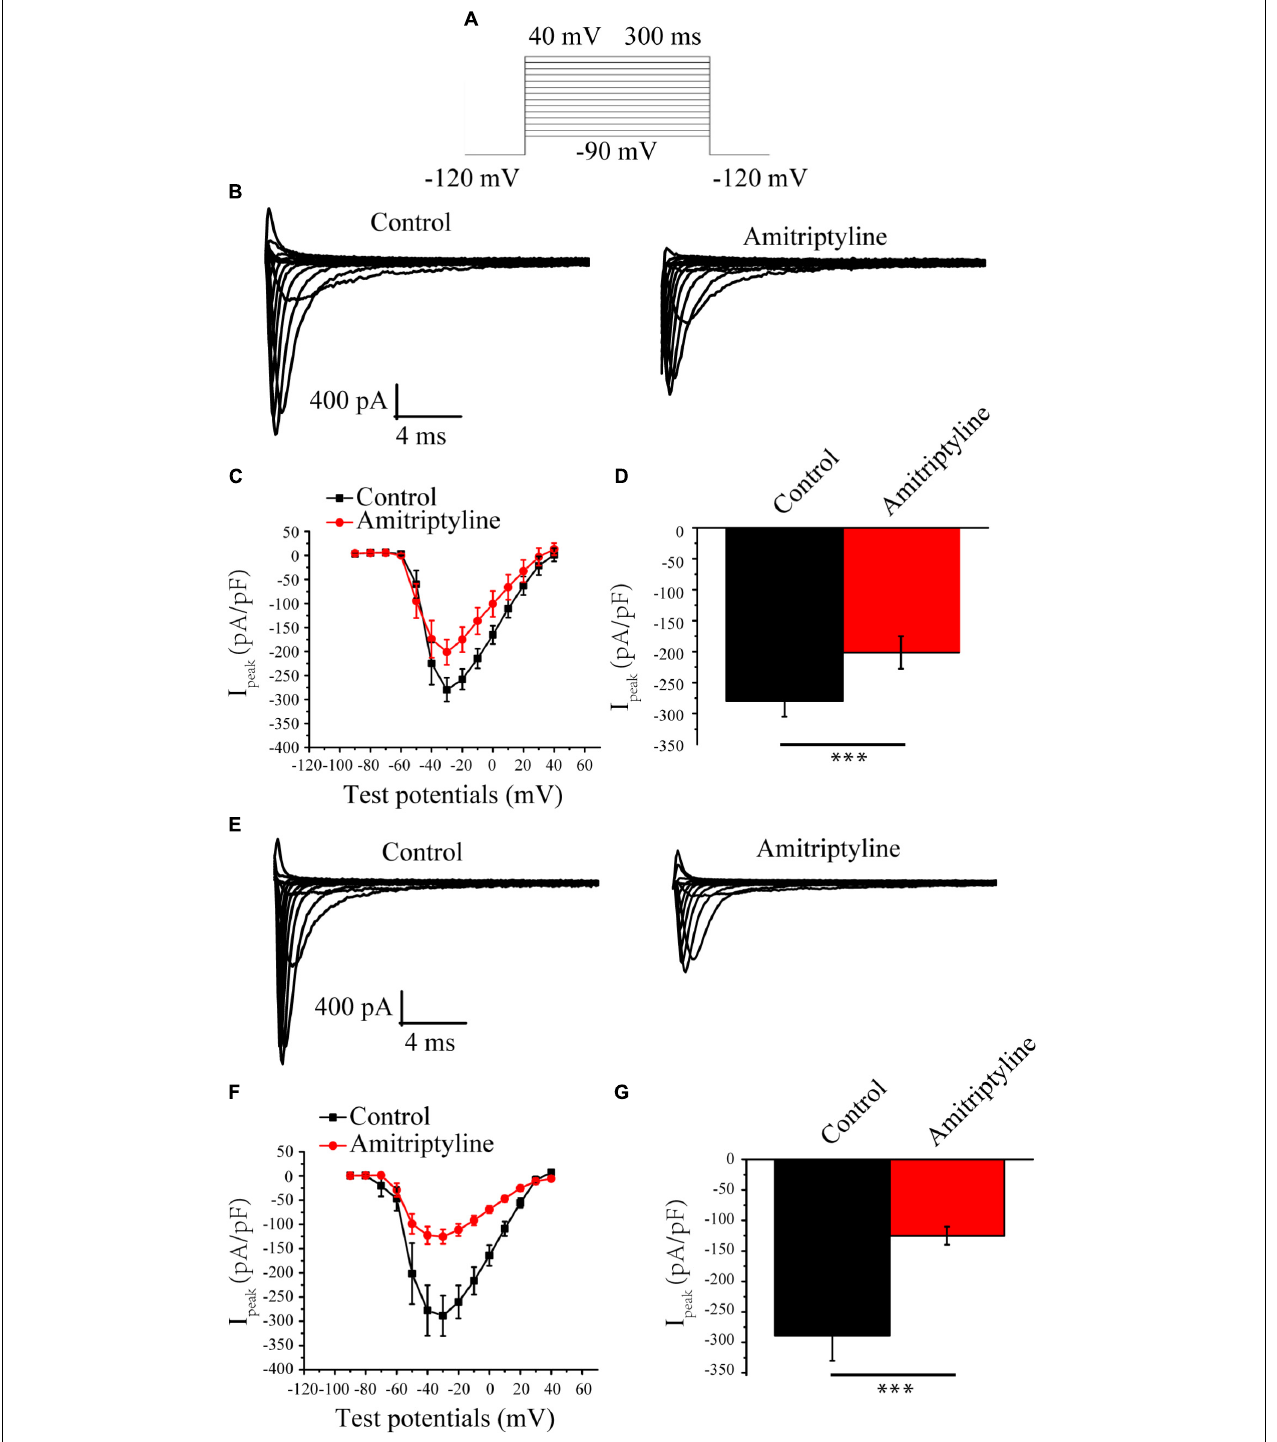
FIGURE 1 | Effect of amitriptyline on Nav1.5 currents. (A) Protocols for I Na eliciting. (B) Representative I Na in control cells and in cells with acute treatments of amitriptyline. (C) I-V curves for control cells and cells with acute treatments of amitriptyline. (D) Analysis of peak I Na densities for the acute effect of amitriptyline. (E) Representative I Na in control cells and cells with long-term treatments of amitriptyline. (F) I-V curves for control cells and cells with long-term treatments of amitriptyline. (G) Analysis of peak I Na densities for the long-term effect of amitriptyline. ∗∗∗ P < 0.001.